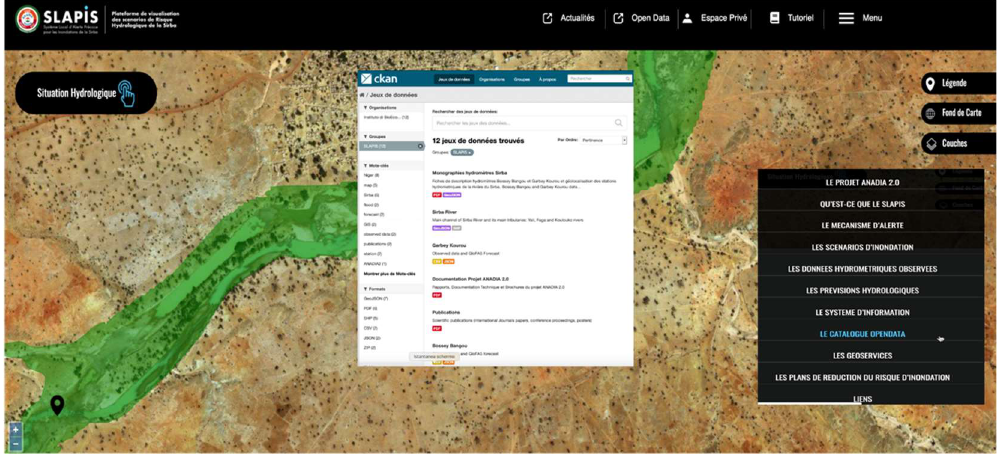
Figure 7. Web application interface: risk scenario and hydrological threshold reached in July 2020.